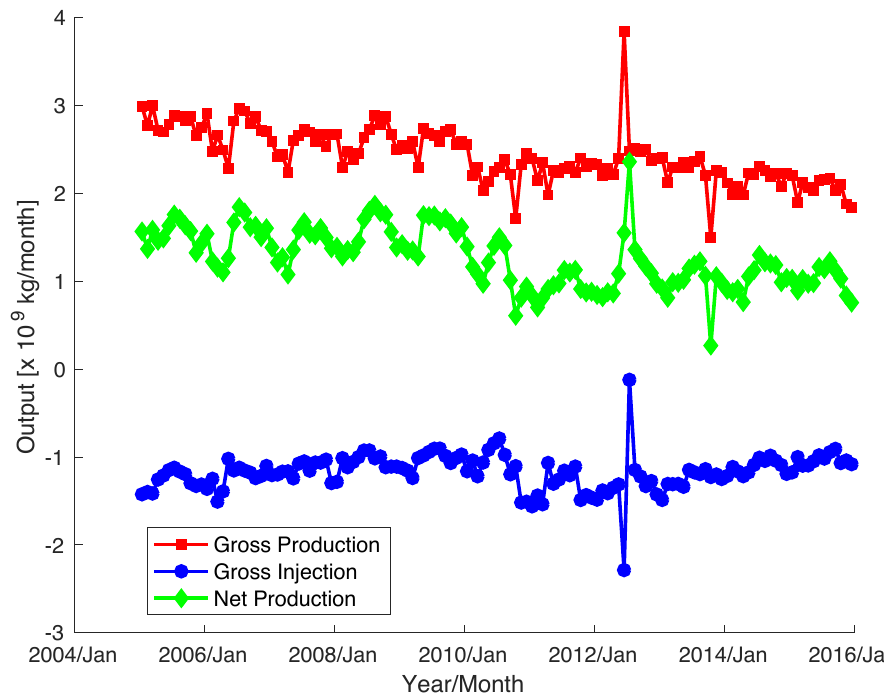
Figure 6. Time series showing rate of gross geothermal injection (blue), gross production (red), and net production (green) in kg/month. Data are from the Division of Oil, Gas, and Geothermal Resources